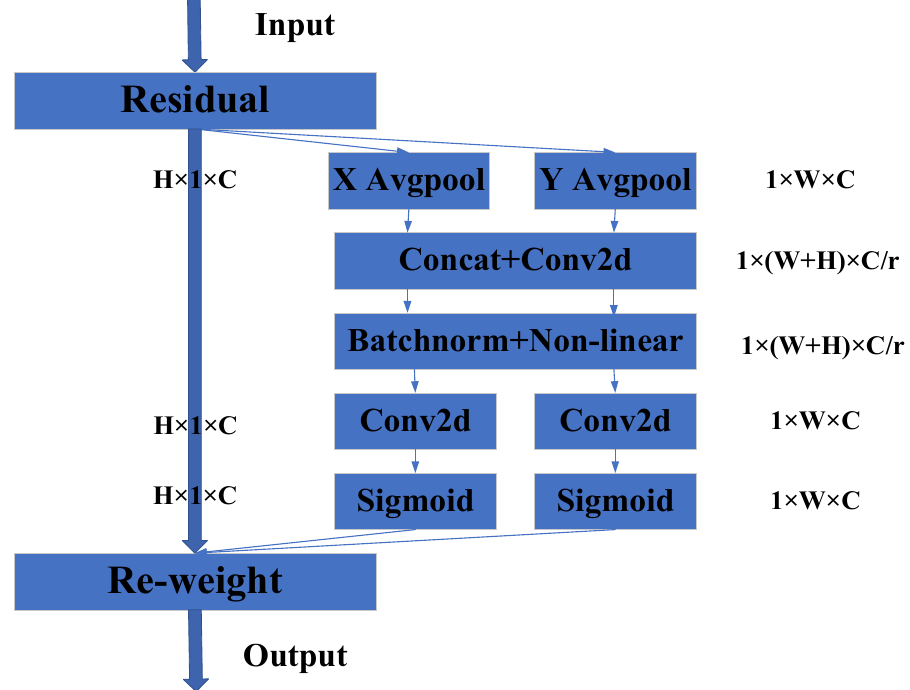
Figure 4. Coordinate attention architecture.